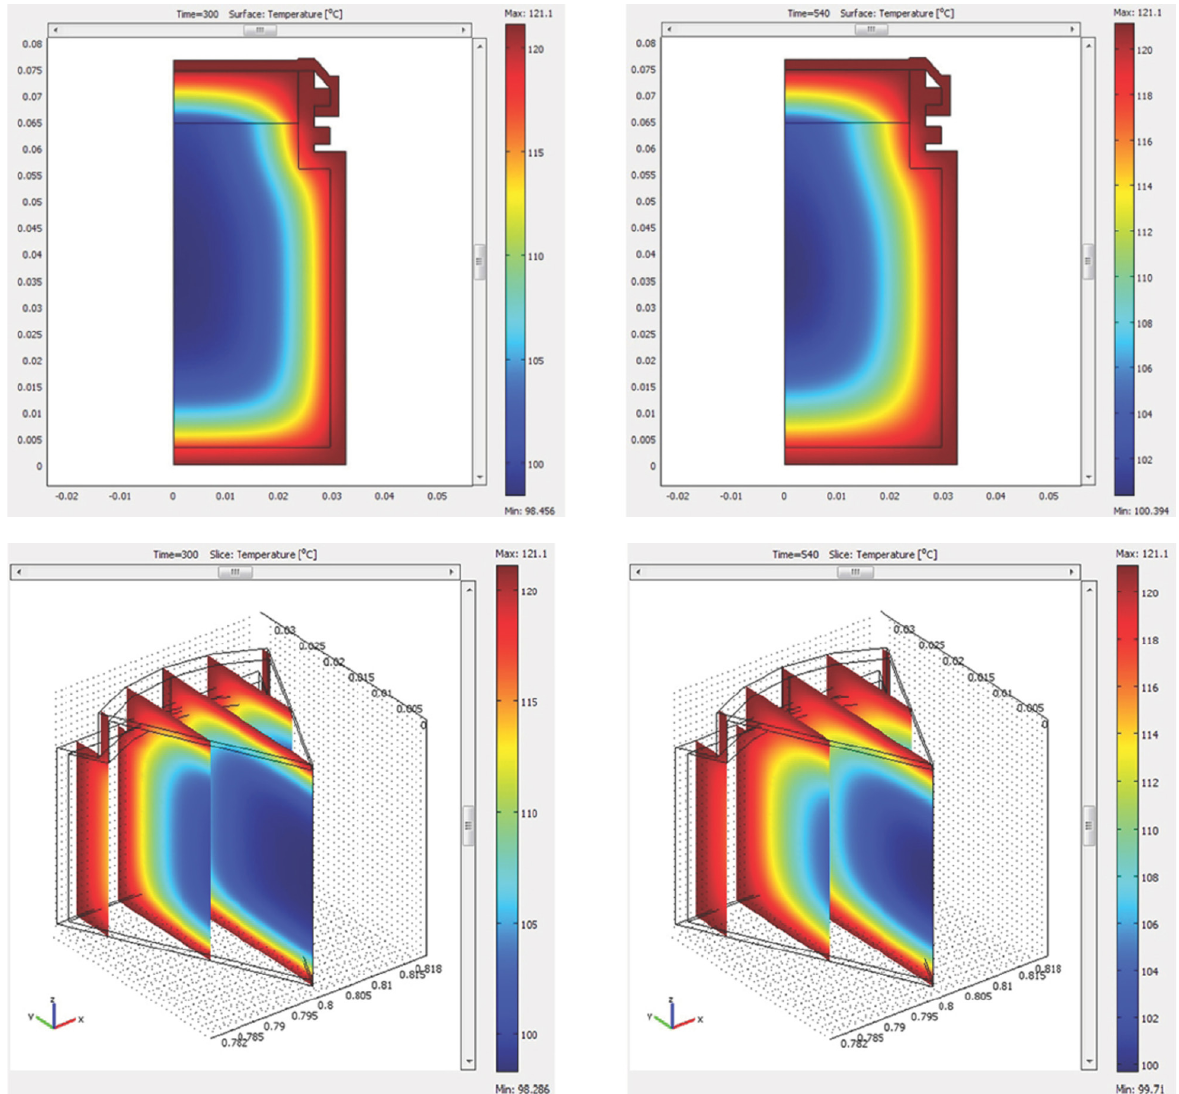
Figure 4. Temperature profiles in each of the domains, predicted by 2D axial symmetry (a) and 3D (b) models at 5 and 9 minutes of thermal